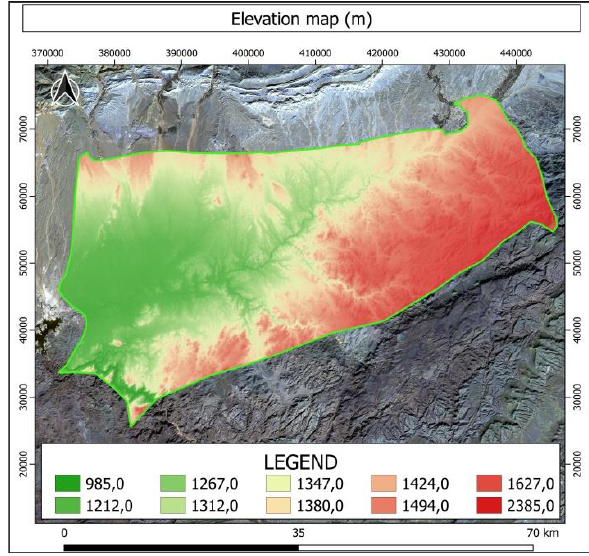
Figure 2: Geological map of the study area.